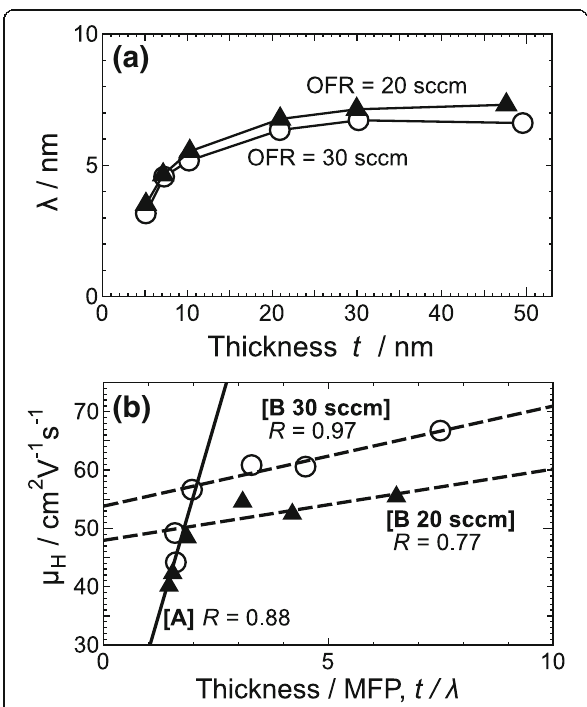
Fig. 7 a Mean free path λ as a function of film thickness t and b relationship between Hall mobility μ H and the ratio of thickness t to λ , t/ λ , for a -ITO films grown at an OFR of 20 sccm (triangles) or of 30 sccm (circles). The solid line [A] and dot-dashed line [B; for each OFR] denote linear fits of the data for t = 5 – 10 nm and t = 10 – 50 nm, respectively. The correlation coefficients R are specified for all fitted